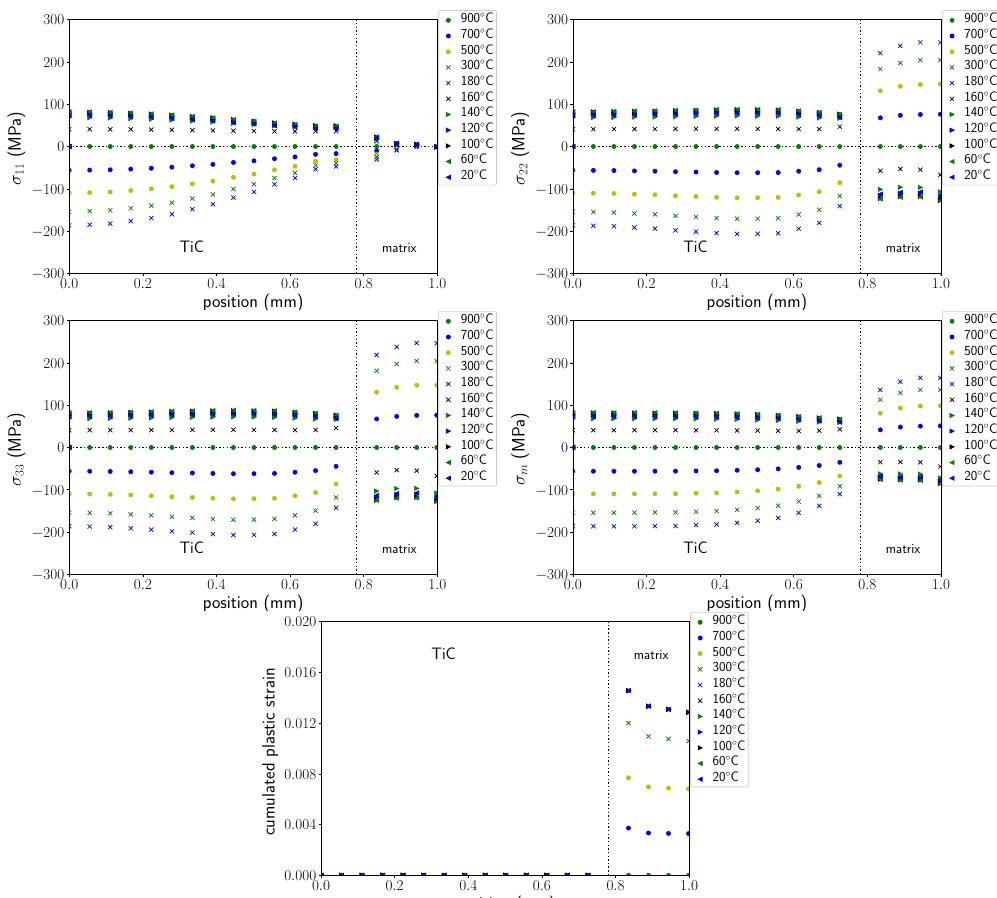
Figure 15. Stresses and cumulated equivalent plastic strain profiles along axis 1 for different